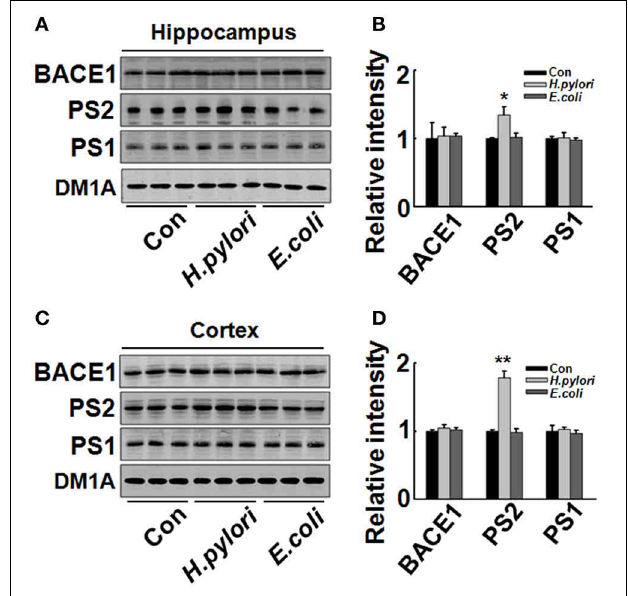
FIGURE 6 | Intraperitoneal injection of H. pylori filtrate induces increased expression of PS-2 in rat hippocampus. The extracts of rat hippocampus and cortex were prepared and the protein levels of BACE-1, PS-1, and PS-2 were measured by Western blotting with site-specific antibodies. DM1A was used as protein loading control. Fifteen micrograms of the protein samples were loaded for BACE-1, PS-1, and PS-2 detection, and 5 μ g for DM1A. (A,C) The protein levels of PS-2 were remarkably increased in H. pylori filtrate-injected rat hippocampus (A) and cortex (C) , while BACE-1 and PS-1 showed no difference among the three groups; B ( p = 0 . 012, F = 8 . 24) and D ( p = 0 . 004, F = 10 . 868) are the quantitative analysis. All the experiments were repeated at least three times. ∗ p < 0 . 05, ∗∗ p < 0 . 01 vs. control group (mean ± SD, n =